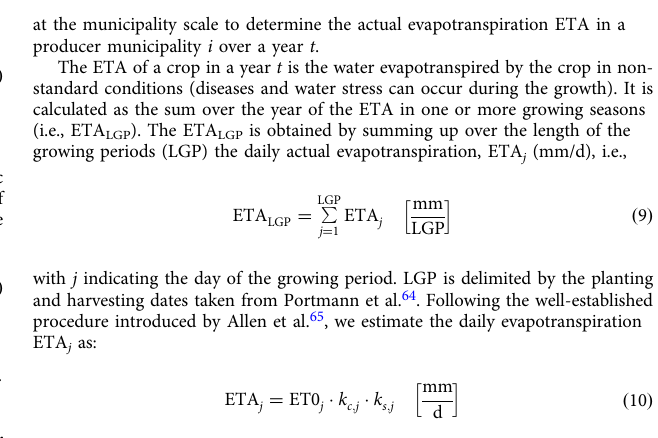
Fig. 5 A water stewardship perspective to sustain the conservation of water resources and secure food supply chains. Inter-relations between science, TNCs, countries and society to synergically sustain the conservation of water resources and secure food supply chains. We frame for each actor the main actions implementable and the main tools available, thanks to the collaboration with another actor of the initiative. For example, Science receives detailed trade data from TNCs, thus assessing their water footprint. In return, TNCs receive useful data on the water risk associated to their activity. With this information, TNCs can lead the corporate initiative and promote sustainable targets that in turn can boost governmental policies and societal awareness. Considering the larger amount of virtual water displaced on average by single TNCs with respect to single countries, and their transnational operational range, TNCs are identi fi ed as the pivotal layer in the virtual water trade that can broaden the biosphere stewardship initiative to water resources in the food